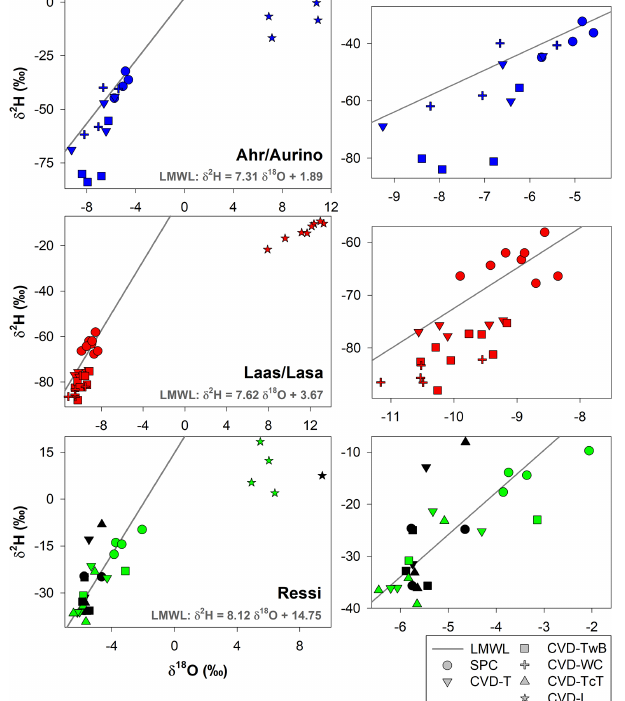
Figure 4. Dual-isotope plot for plant water samples extracted by Scholander-type pressure chamber (SPC) and cryogenic vacuum distillation (CVD) for different plant tissues (CVD-T, CVD-TwB, CVD-WC, CVD-TcT, and CVD-L indicate samples extracted by CVD from twig without bark, twig with bark, wood core, twig close to the trunk of the tree, and leaves, respectively) and species (alder, apple, chestnut, and beech indicated in blue, red, green, and black, respectively). Local Meteoric Water Lines (LMWLs) of the three study sites are plotted in gray: Ahr/Aurino: δ 2 H = 7 . 31 × δ 18 O + 1 . 89 (Engel et al., 2022), Laas/Lasa: δ 2 H = 7 . 62 × δ 18 O + 3 . 67 (Penna et al., 2021), Ressi: δ 2 H = 8 . 12 × δ 18 O + 14 . 75 (Marchina et al., 2020). The three plots on the right column represent a zoom in on SPC, CVD-T, CVD-TwB, CVD-WC, and CVD-TcT samples.